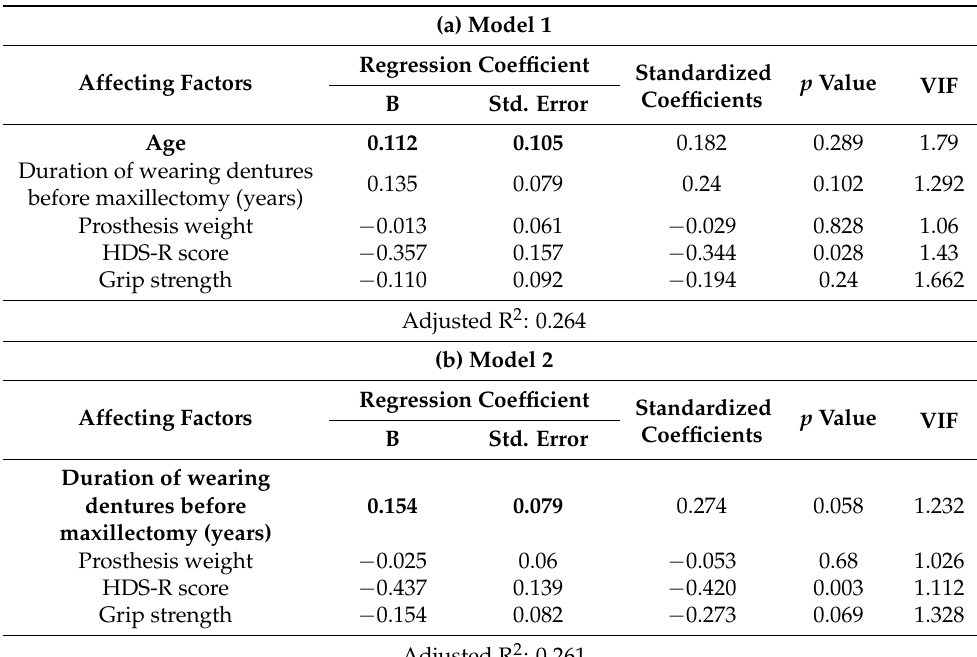
Table 7. Affecting factors for prosthesis insertion time in patients with